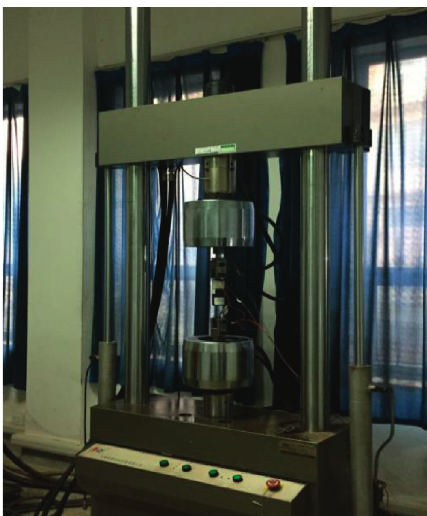
Figure 1: Testing system of mechanical performance of the MR